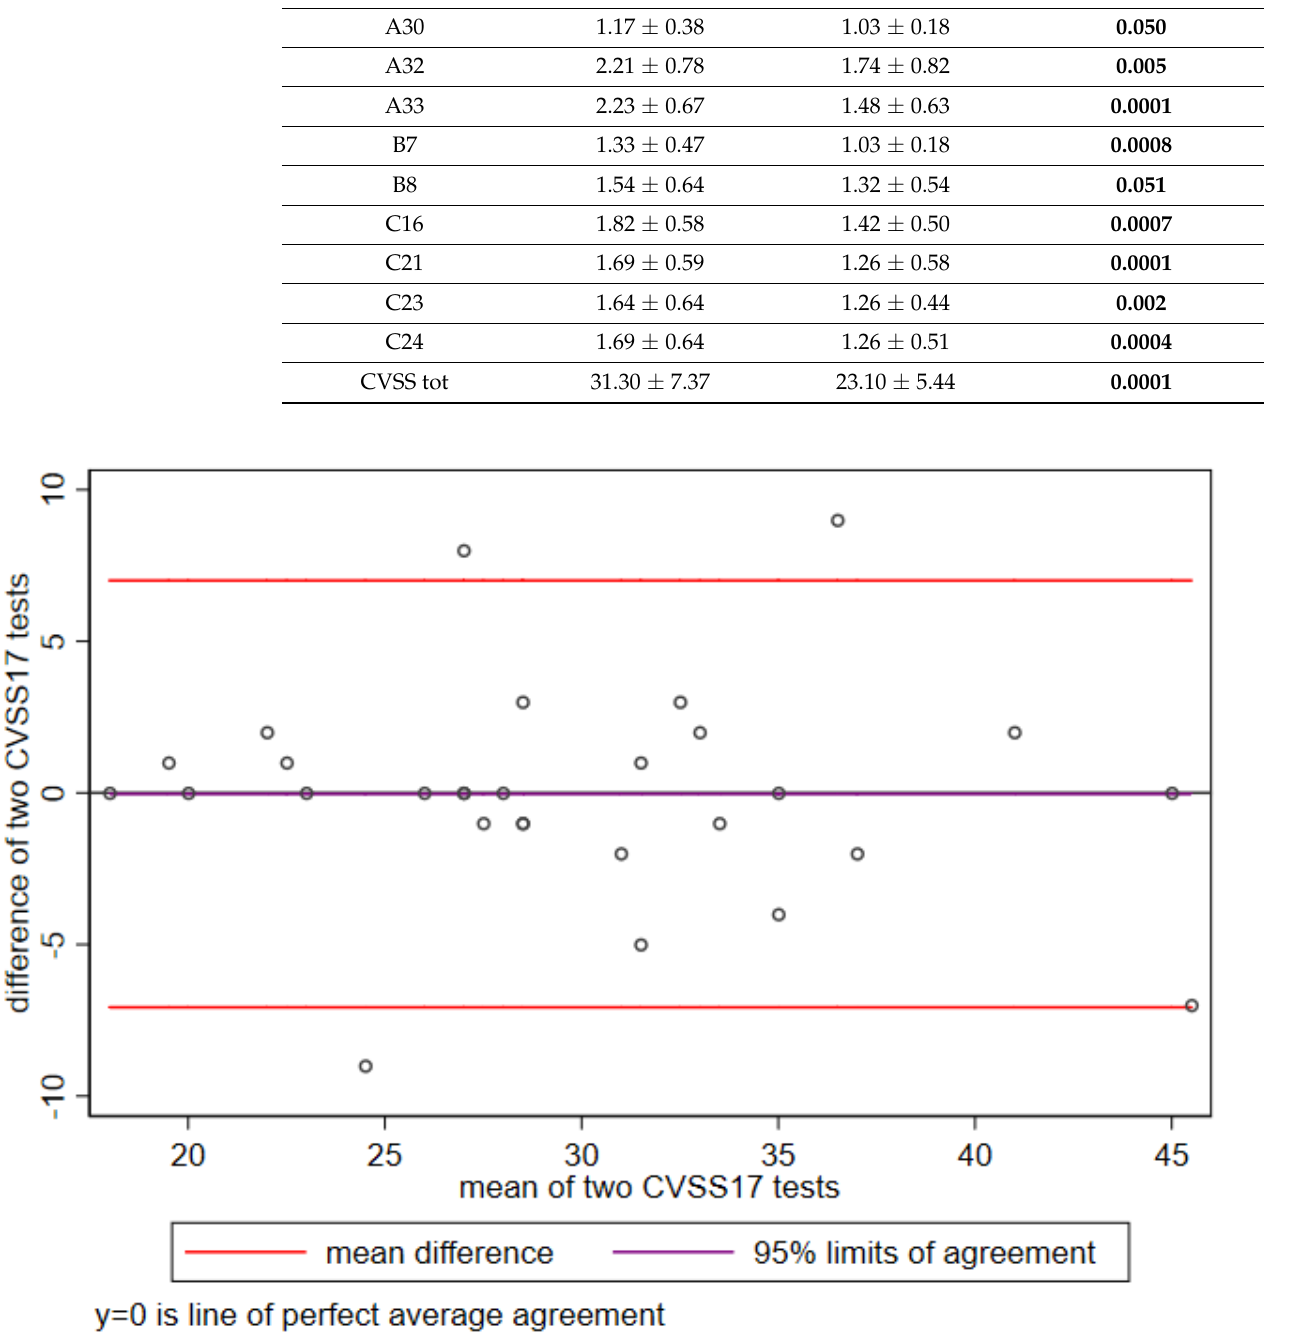
Figure 1. Reliability: test–retest for temporal stability of CVSS17 in a random subset of 20 subjects. Association between CVSS17 and patients’ characteristics (Table 4) was found for age, gender, years worked at a VDT, years since starting using a VDT, time spent on breaks, BCVA, tf-BUT, corneal staining, use of lacrimal substitutes, presbyopia and GSS (both symptoms and function). Of note, the effect size of the association between the CVSS17 score with the GSS symptom scale ( − 0.287, p < 0.001) was higher than with the GSS